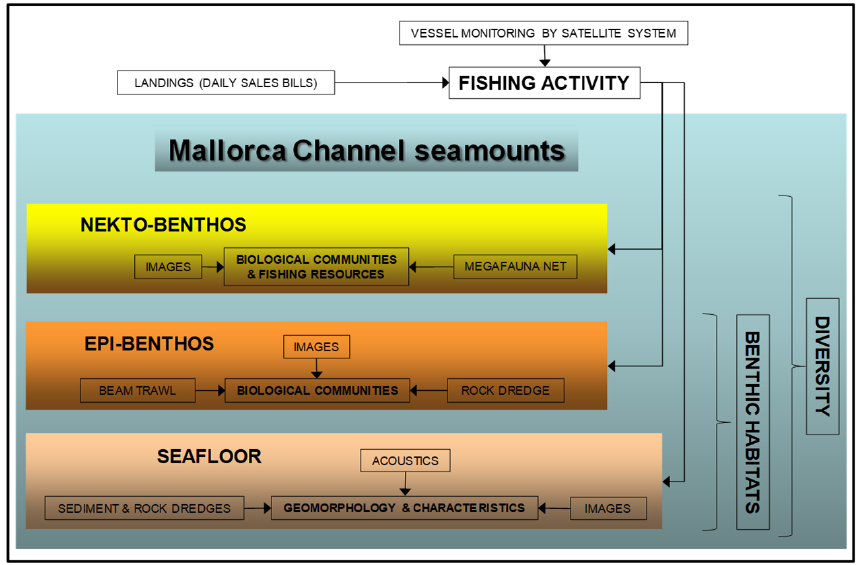
Figure 2. Scheme of the sampling strategy applied during the INTEMARES project in the study of the Ses Olives, Ausias March, and Emile Baudot seamounts of the Mallorca Channel (Balearic Islands, western Mediterranean).